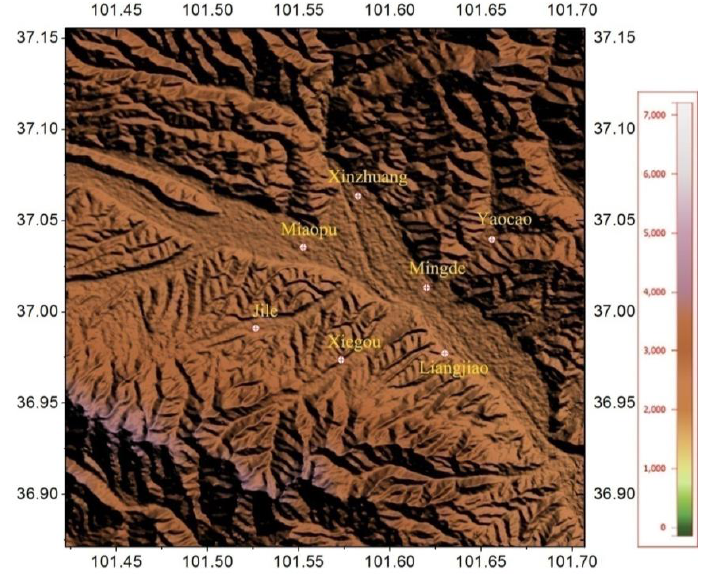
Figure 1. Map of the measurement stations comprising the Composite Observing.